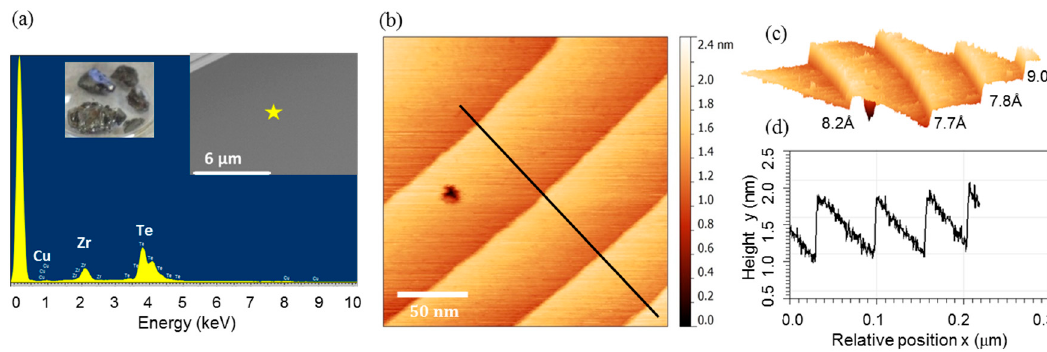
Figure 3. ( a ) Scanning electron microscope (SEM) images, and energy-dispersion X-ray spectrum (EDS) of Cu 0.05 ZrTe 3 , the inserts are a photo image of the crystal (left) and a SEM image (right) in which the star is the sampling position of EDS. ( b ) STM image of Cu 0.05 ZrTe 3 (200 nm × 200 nm) using W tip, I tunneling = 1.0 nA, bias = 20 mV, various terraces are exhibited; ( c ) 3D image of ( b ), the image is rotated ( ϕ = 60°) and tilted ( ϑ = − 75°) from ( b ). ( d ) line profile of ( b ), step size = 8.2 ± 0.5 Å (smaller than 1.0 nm of the c -axis but close to the metal-metal distance of ZrTe 3 surface at 7.1 Å).